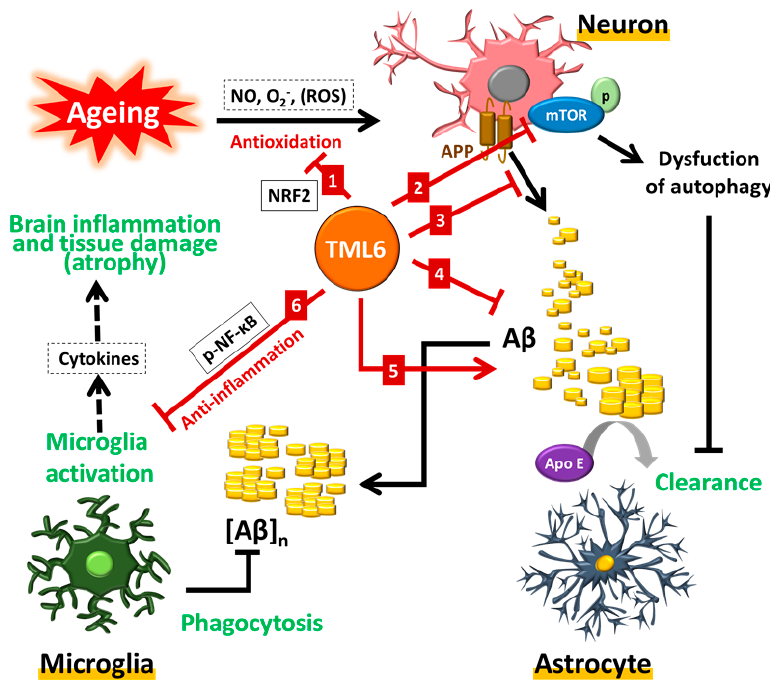
Figure 6. A hypothetical scheme on the potential action mechanism of TML-6 in the therapy of Alzheimer's disease. Curcumin derivative-TML-6 treatments can induce (1) transcriptional activation of the Nrf2 promoter, which can reduce free radicals, the hallmark of the aging process; (2) following the aging process, the dysfunction of autophagy machinery and activation of mTOR will reduce the autophagolysosomal function to remove the misfolded proteins and lead to the accumulation of A β . TML-6 can effectively inhibit the phosphorylation of mTOR and maintain the normal function of autophagy to assure A β clearance; (3) TML6 can inhibit the production of A β from APP and (4) suppress the synthesis and secretion of A β from neurons; (5) TML6 can transcriptionally activate APOE and enhance the clearance of A β ; (6) TML6 can inhibit the activation of microglial cells and reduce inflammatory injuries in the brain. The future design of therapeutics should combine targeting APP/the A β cascade and improving aging-related biological processes.